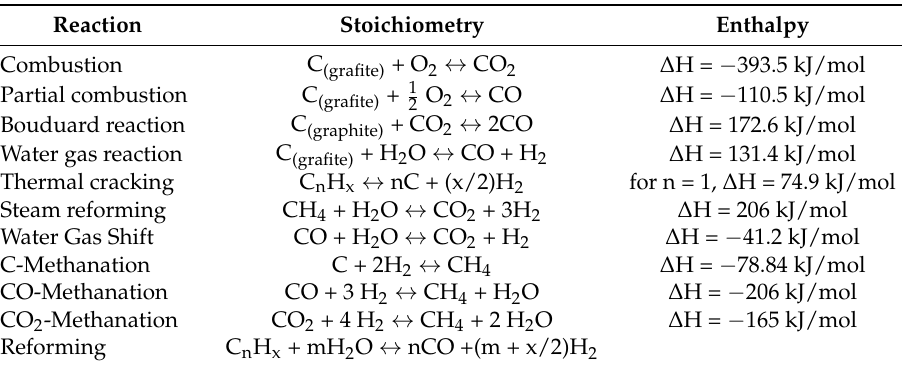
Table 2. Main reactions of gasification.